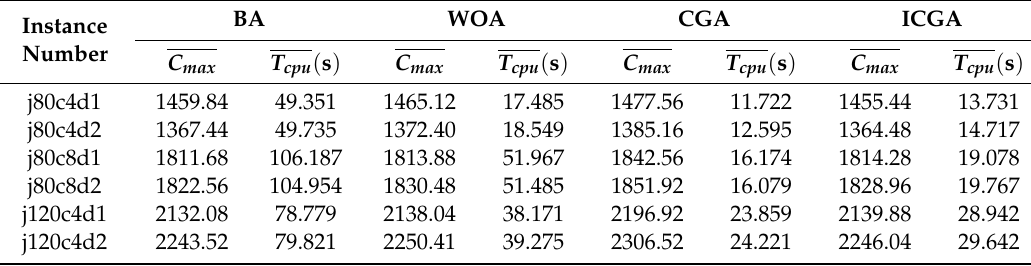
Table 3. Large-scale data test